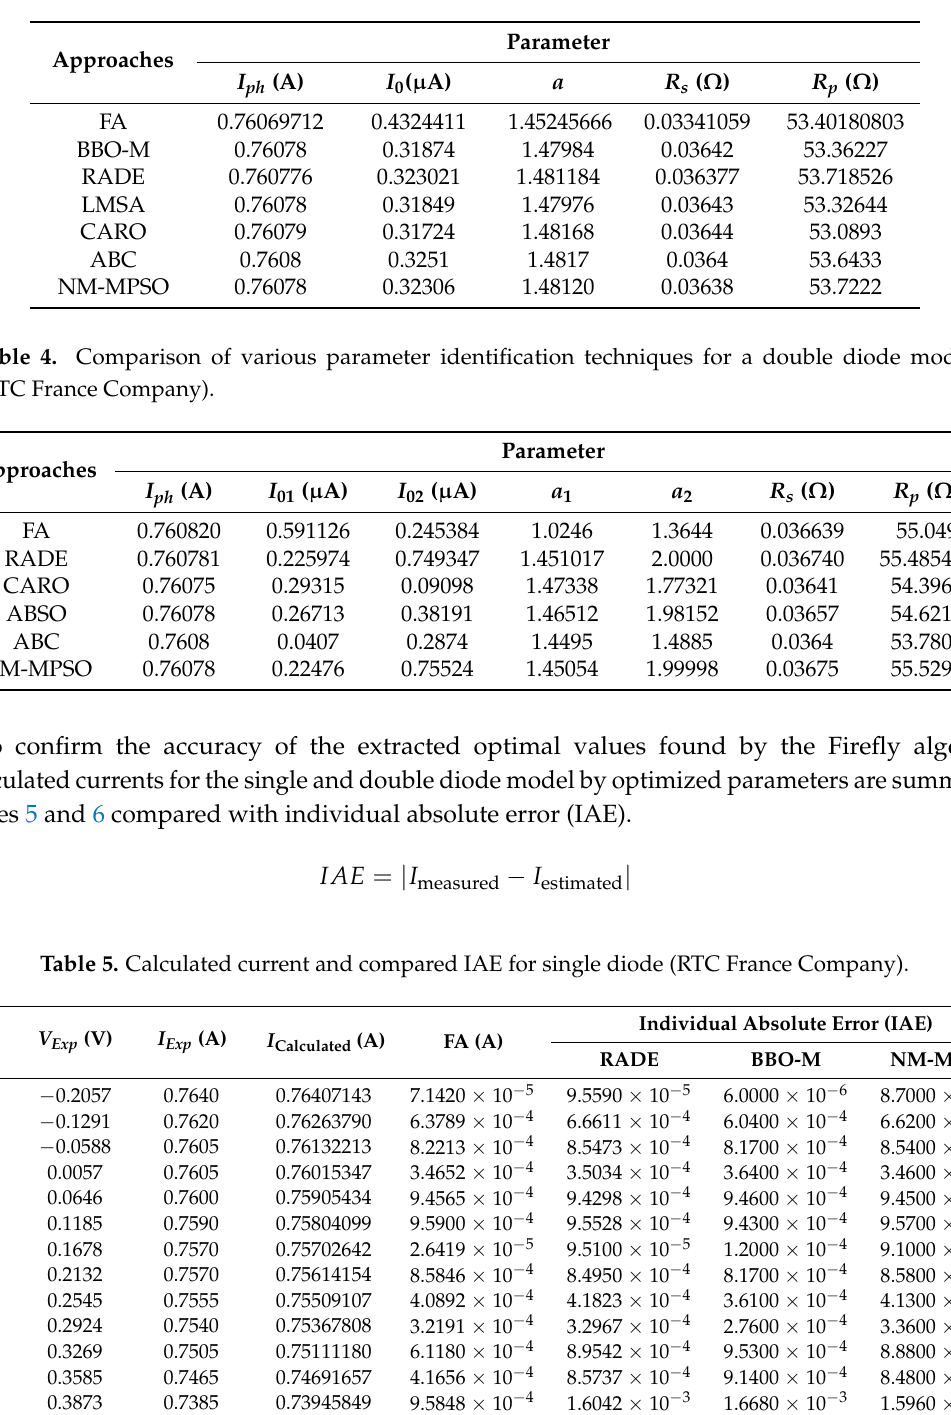
Table 3. Comparison of various parameter identification techniques for single diode model (RTC France Company). FA: Firefly Algorithm; BBO-M: Biogeography-Based Optimization with Mutation strategies; RADE: Repaired Adaptive Differential Evolution; LMSA: Levenberg-Marquardt algorithm combined with Simulated Annealing; CARO: Chaotic Asexual Reproduction Optimization; ABC: Artificial Bee Colony optimization; NM-MPSO: hybrid Nelder-Mead and Modified Particle Swarm Optimization.